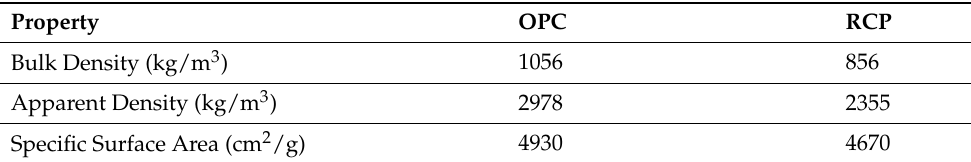
Table 15. Physical properties of RCP [173].